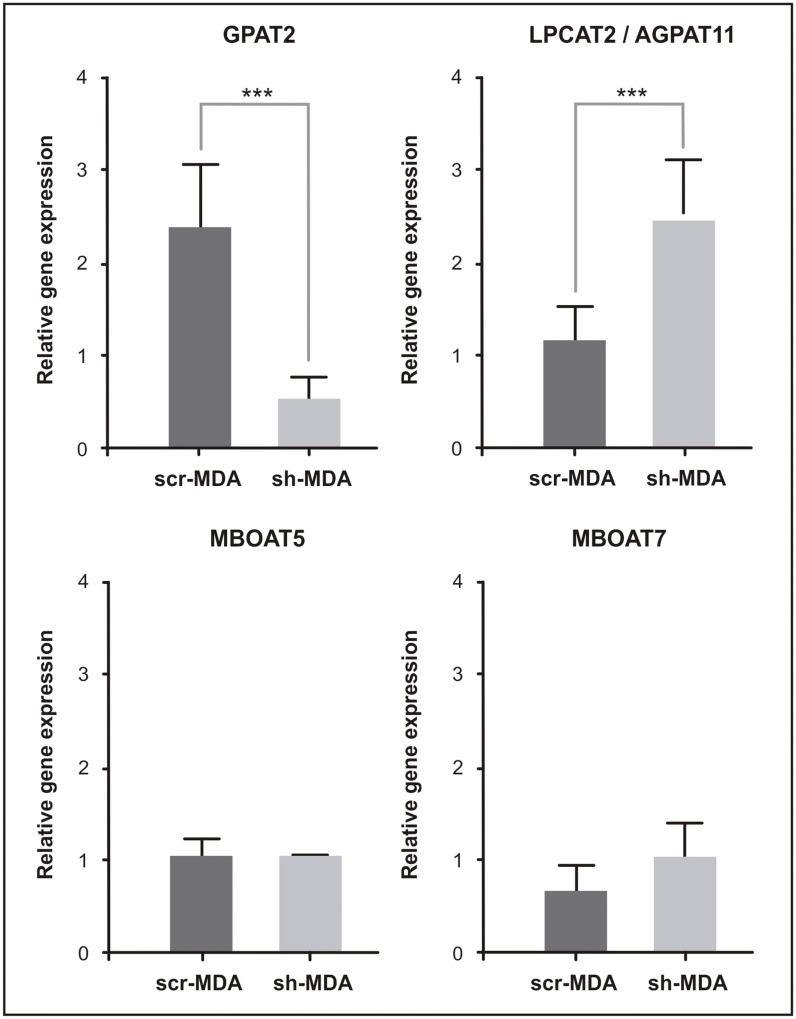
mRNA expression of acyltransferases involved in arachidonic acid metabolism.Total RNA from scr-MDA and sh-MDA cells was extracted, subjected to cDNA synthesis, and amplified by qRT-PCR with primers for human GPAT2, AGPAT11, MBOAT5 and MBOAT7 genes and normalizing expression levels to that of TATA-Box binding protein (TBP) housekeeping gene (*** p<0.001. ANOVA-Tukey test).